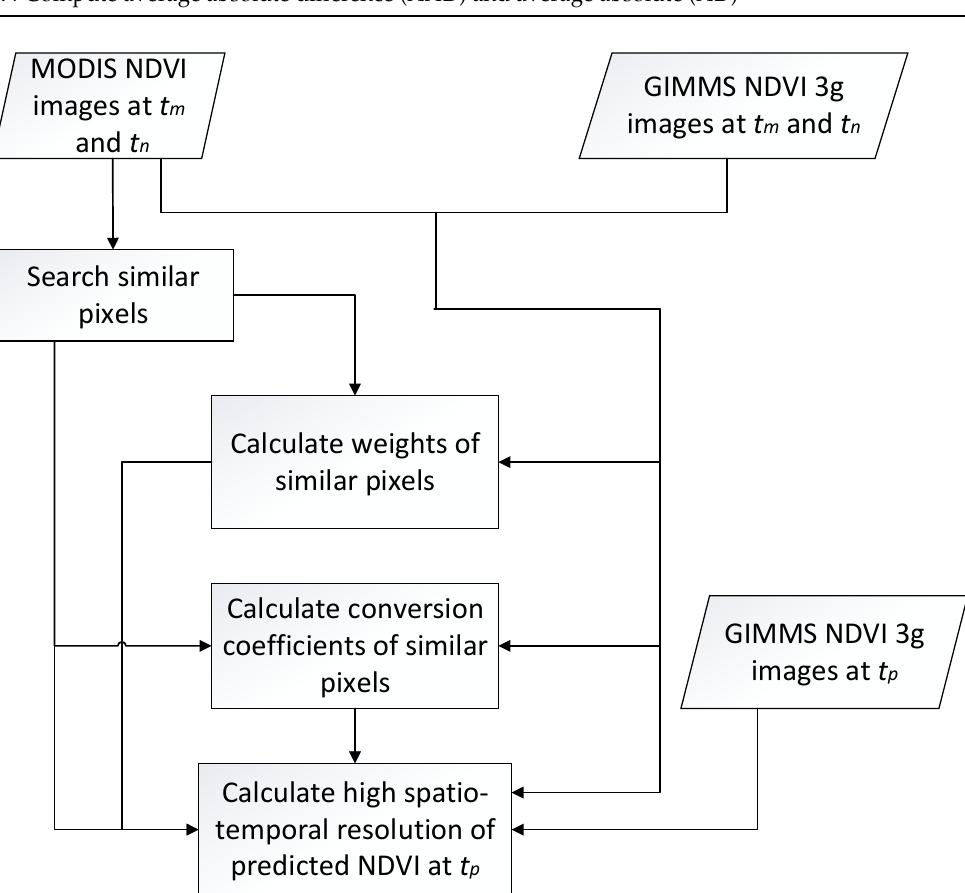
Figure 1. Schematic explanation of the enhanced spatial and temporal adaptive reflectance fusion model (ESTARFM) for fusing GIMMS NDVI3g and MODIS NDVI.